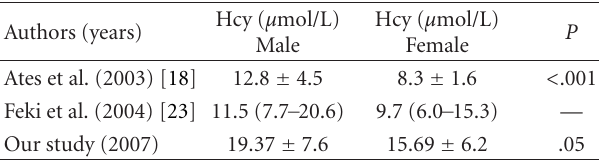
Table 5: Homocysteine and